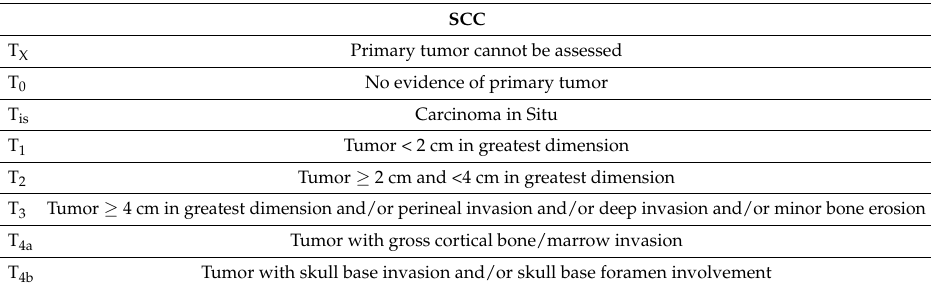
Table 1. American Joint Committee on Cancer Tumor (T) Classification, 8th Edition [65].